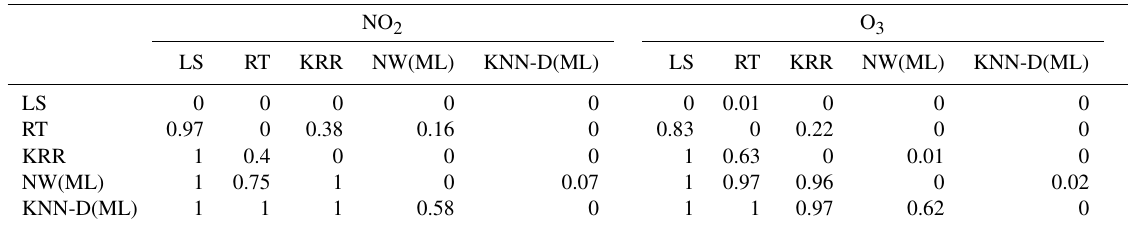
Table 3. Results of the pairwise Wilcoxon signed-rank tests across all model types. We refer the reader to Sect. 5.1.1 for a discussion on how to interpret this table. KNN-D(ML) beats every other algorithm comprehensively and is scarcely ever beaten (with the exception of NW(ML), which KNN-D(ML) still beats 58% of the time for NO 2 and 62% of the time for O 3 ). The overall ranking of the algorithms